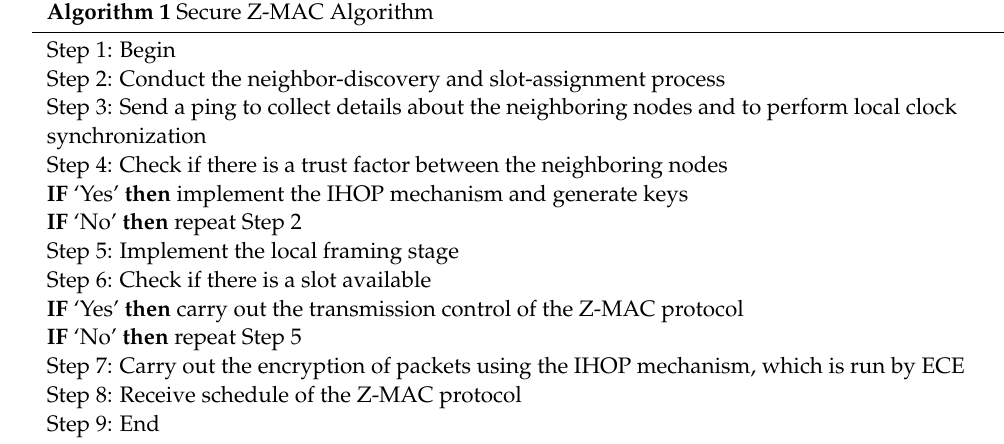
Algorithm 1 Secure Z-MAC